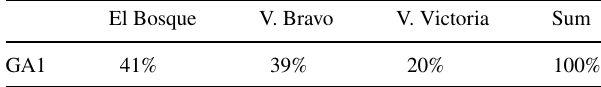
Table 2 Percentage of total annual extraction supplied by each reser‑ voir, found with genetic algorithm GA1